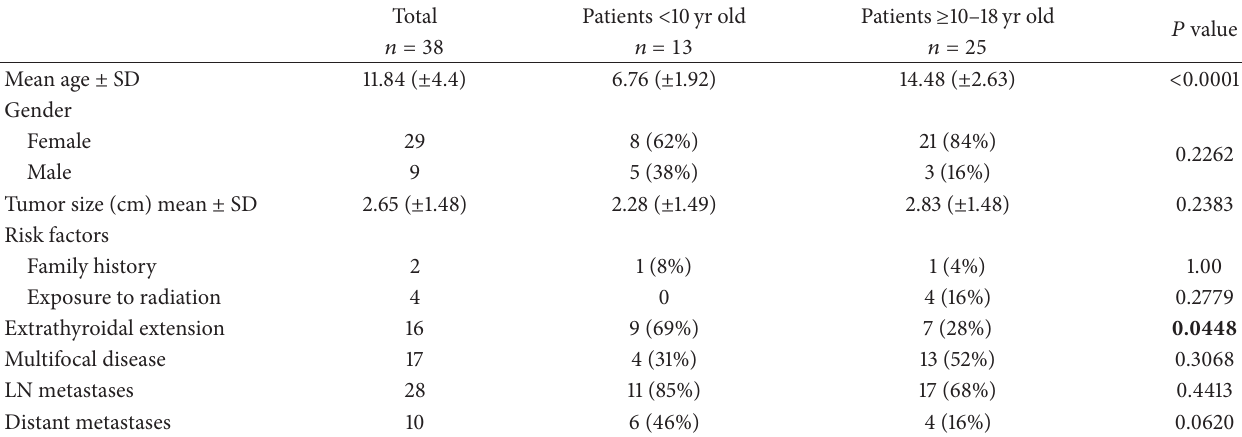
Table 1: Summary of the clinicopathological features of pediatric thyroid